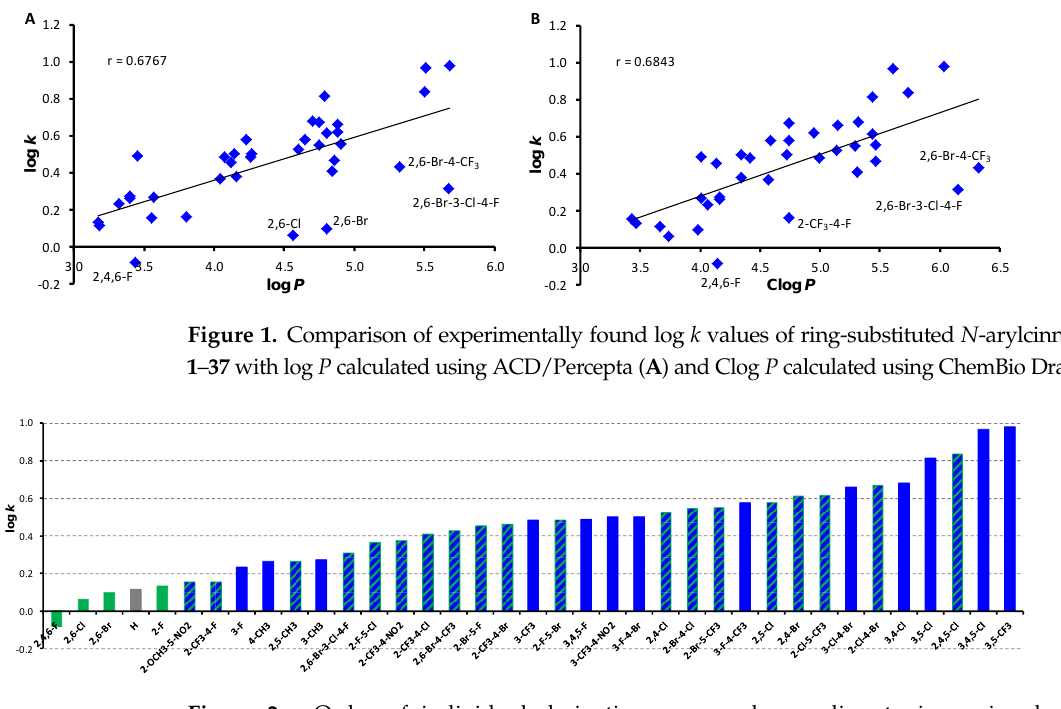
Molecules 2022 , 27 , x FOR PEER REVIEW 5 of 11